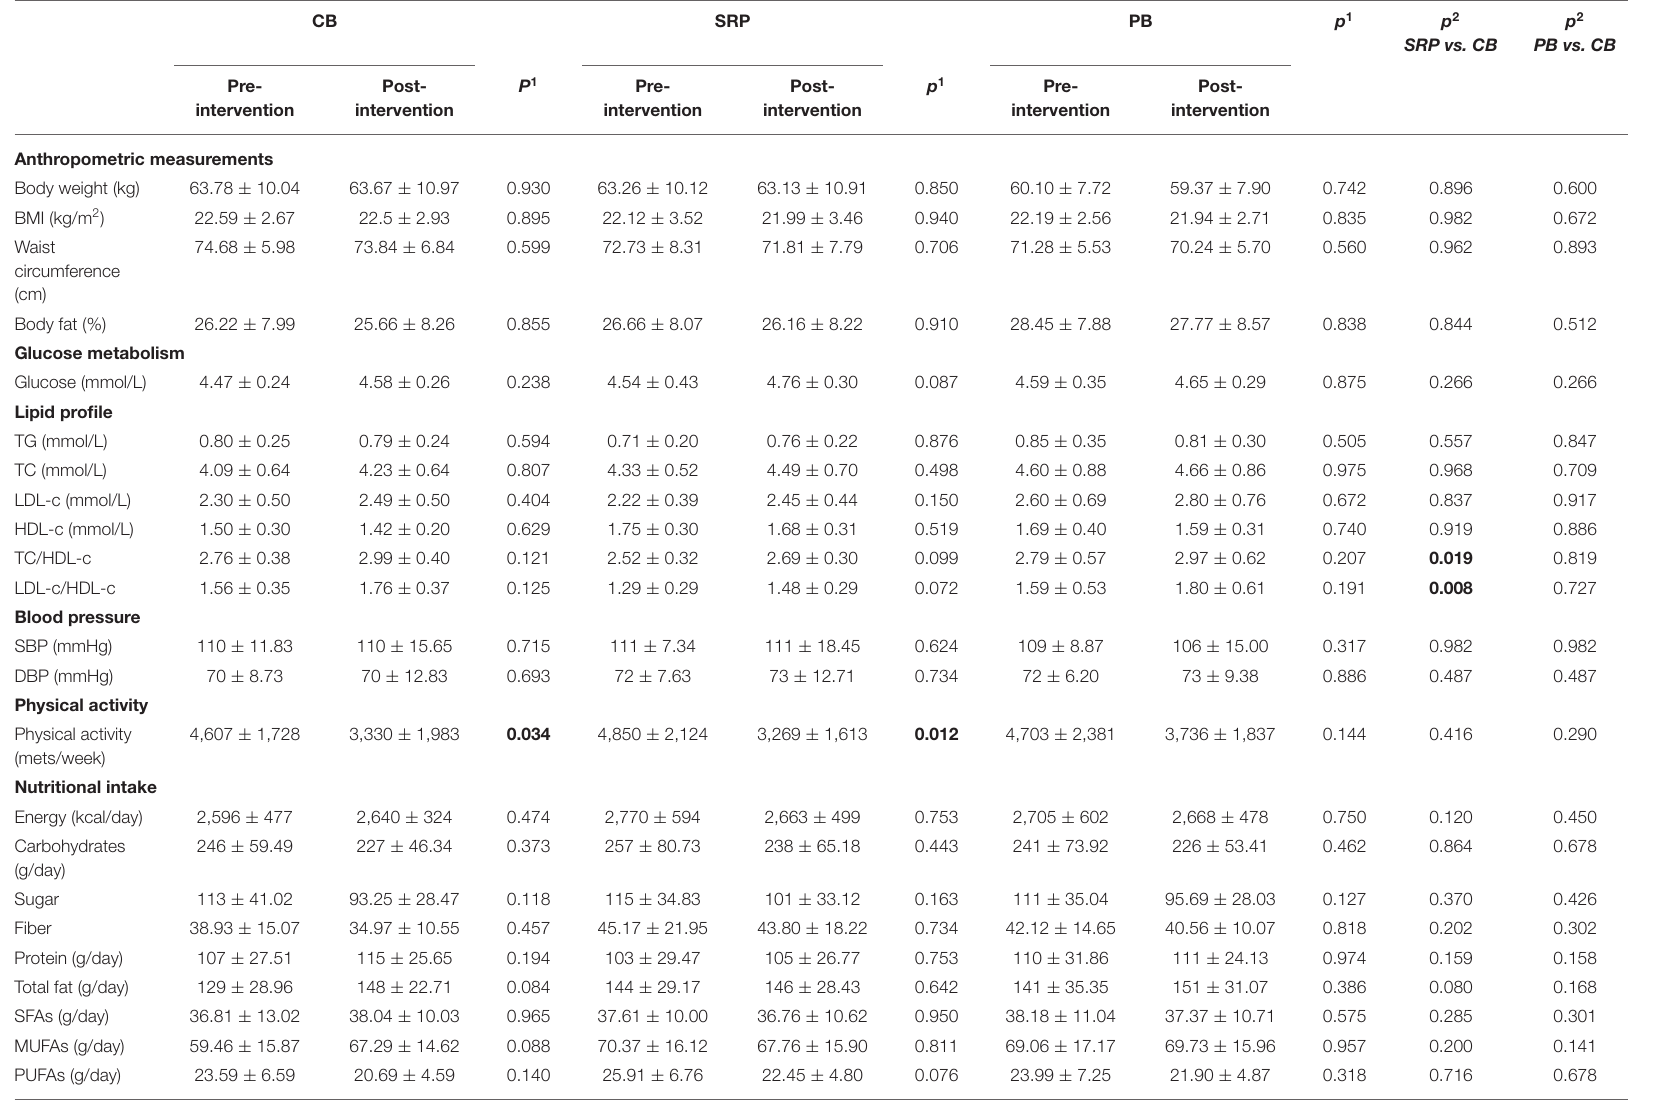
TABLE 2 | Health outcomes, physical activity, and nutritional intake of healthy adults from the ARISTOTLE